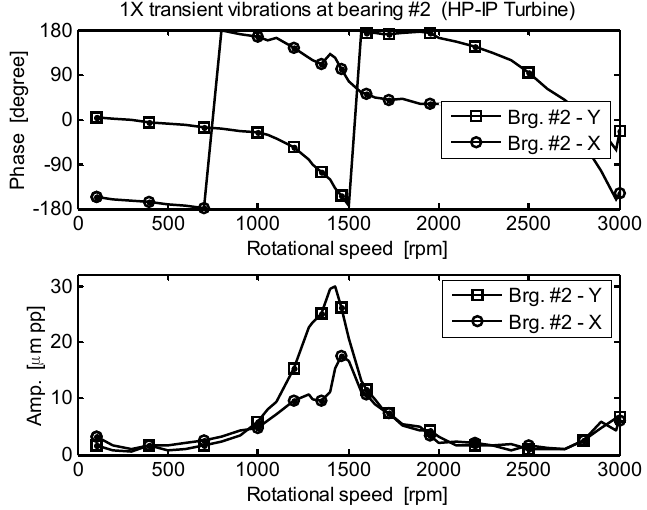
Fig. 5. Bode plot of the 1X transient vibrations measured at bearing #2 during a reference runup. of the oil- fi lm journal bearings #1 and #2 this fi rst resonance was split into two fairly spaced fl exural critical